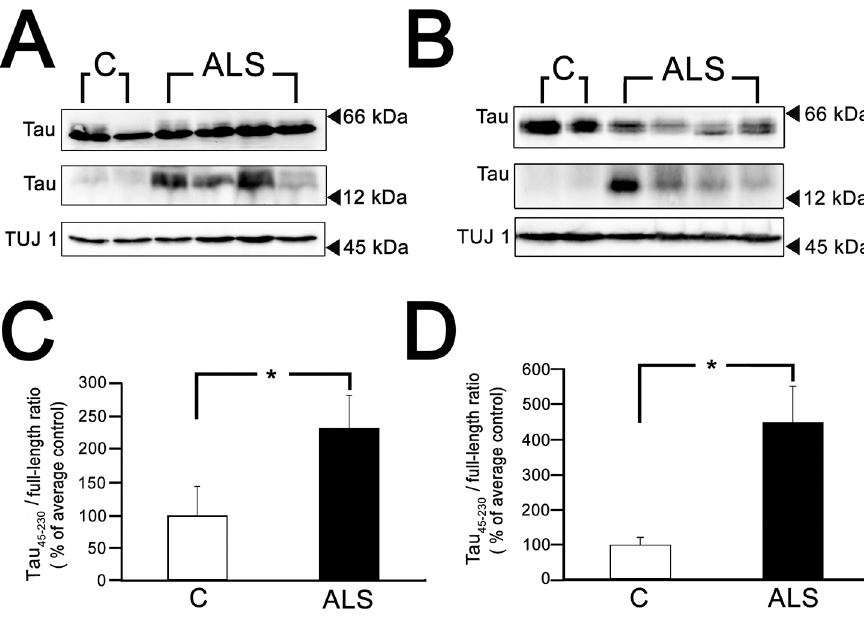
were detected in ALS spinal cords. (A and B) Quantita- Figure 1. High levels of tau 45-230 tive Western blot analysis of tau content in representative homogenates prepared from postmortem samples of the anterior horn of lumbar (A) and cervical (B) spinal cords from control (C) and ALS (ALS) subjects. Immunoreactive bands at 17 kDa apparent molecular weight corresponding to tau were readily detectable in ALS samples. (C and D) 45-230 Graphs show the ratios of tau /full-length tau in control and ALS subjects. Numbers 45-230 represent the mean ± SEM of control (n = 7) and ALS (lumbar n = 22, cervical n = 10) samples. Values are expressed as percentage of controls, considering the values ob- tained in control subjects as 100%. Class III β tubulin (TUJ1) was used as loading control. *Differs from control subjects; P <